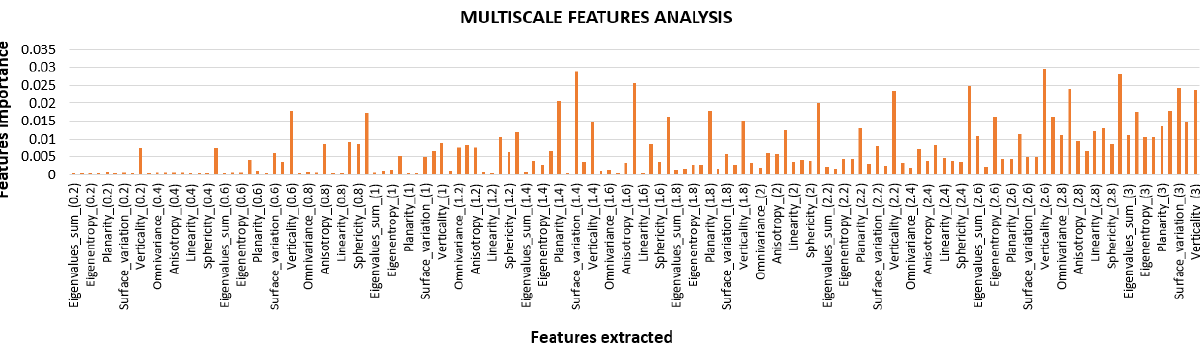
Table 2. Features importance ranking for a multi-scale classification of the Basilica dataset.